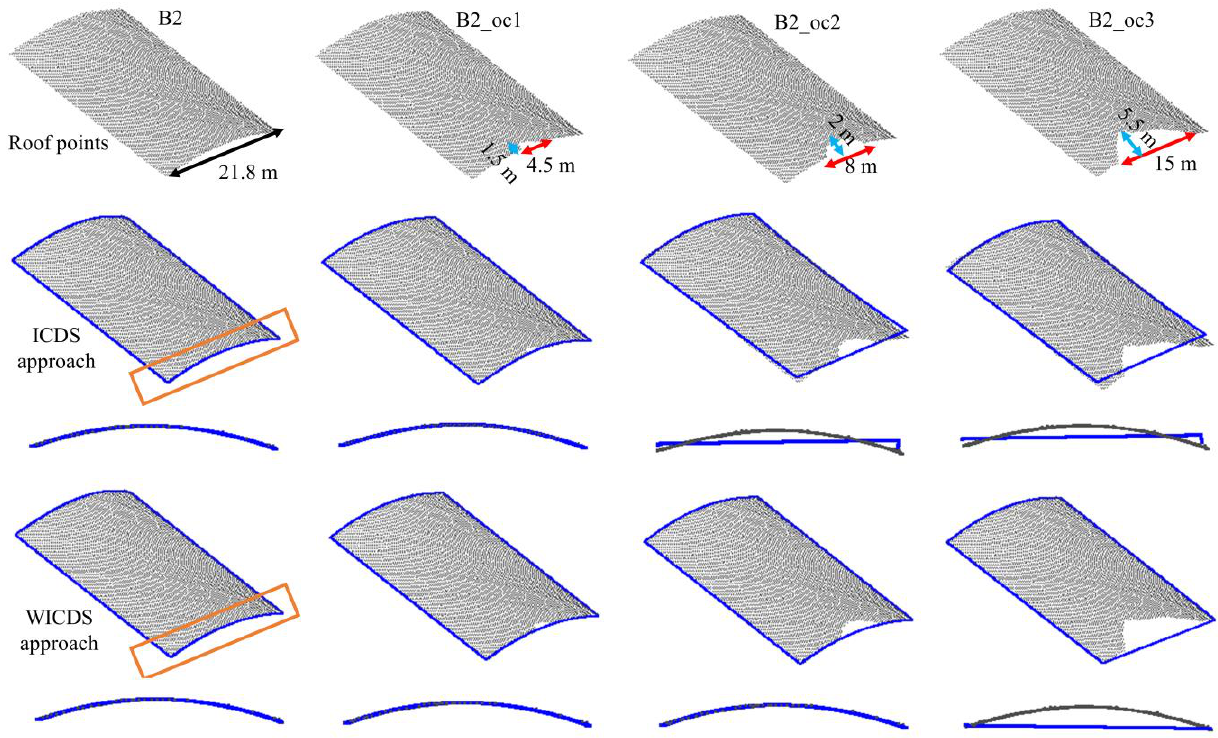
Figure 6. Curved building with different sizes of occlusion areas. Roof points ( First row ), modeled boundary (blue line) using ICDS ( Second row ) and WICDS ( Third row ).